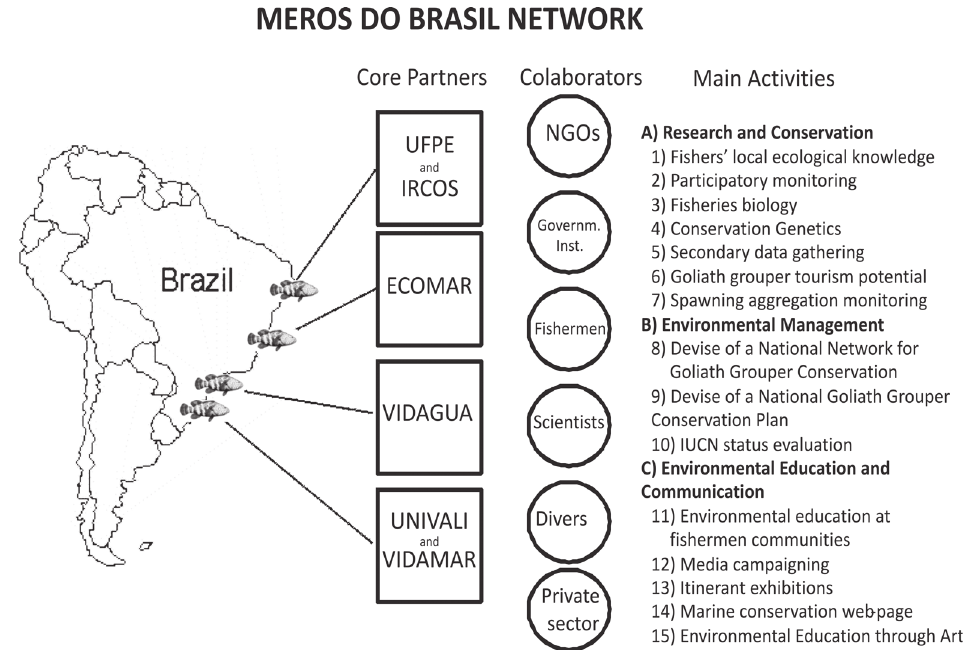
Fig. 3. Schematic representation of the “Meros do Brasil Network”, a multi-institutional partnership promoting coordinated research, environmental education, communication and management actions directed to goliath grouper Epinephelus itajara and mangrove, coral and rocky reef ecosystems in